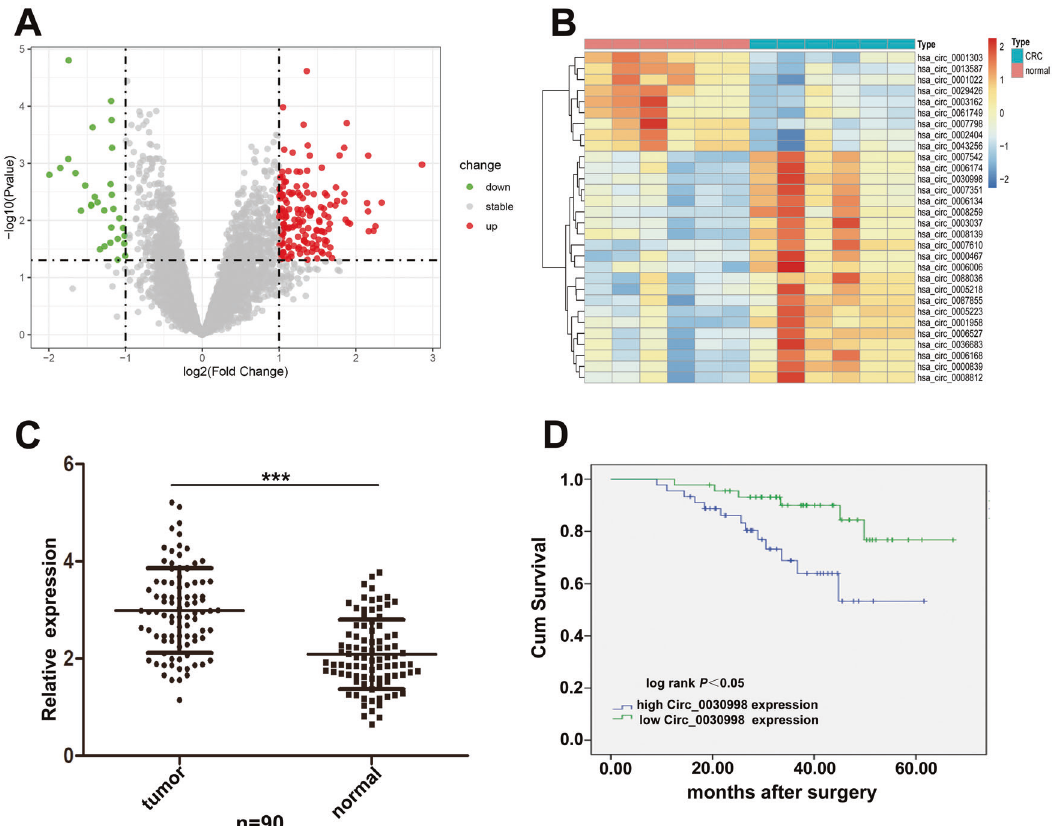
Fig. 1 Circ_0030998 was upregulated in CRC tissues and associated with poor prognosis of CRC patients. A The difference of CircRNAs expression between CRC tissues and matched neighboring normal tissues exhibited by the volcano plots generated from microarray data GSE138589. B The heat map of the top 30 CircRNAs with the most signi fi cant differences from data GSE138589. C Relative expression of Circ_0030998 in CRC tissues and paired adjacent normal tissues ( n = 90). D Correlation between Circ_0030998 expression and CRC patients ’ survival. *** p <